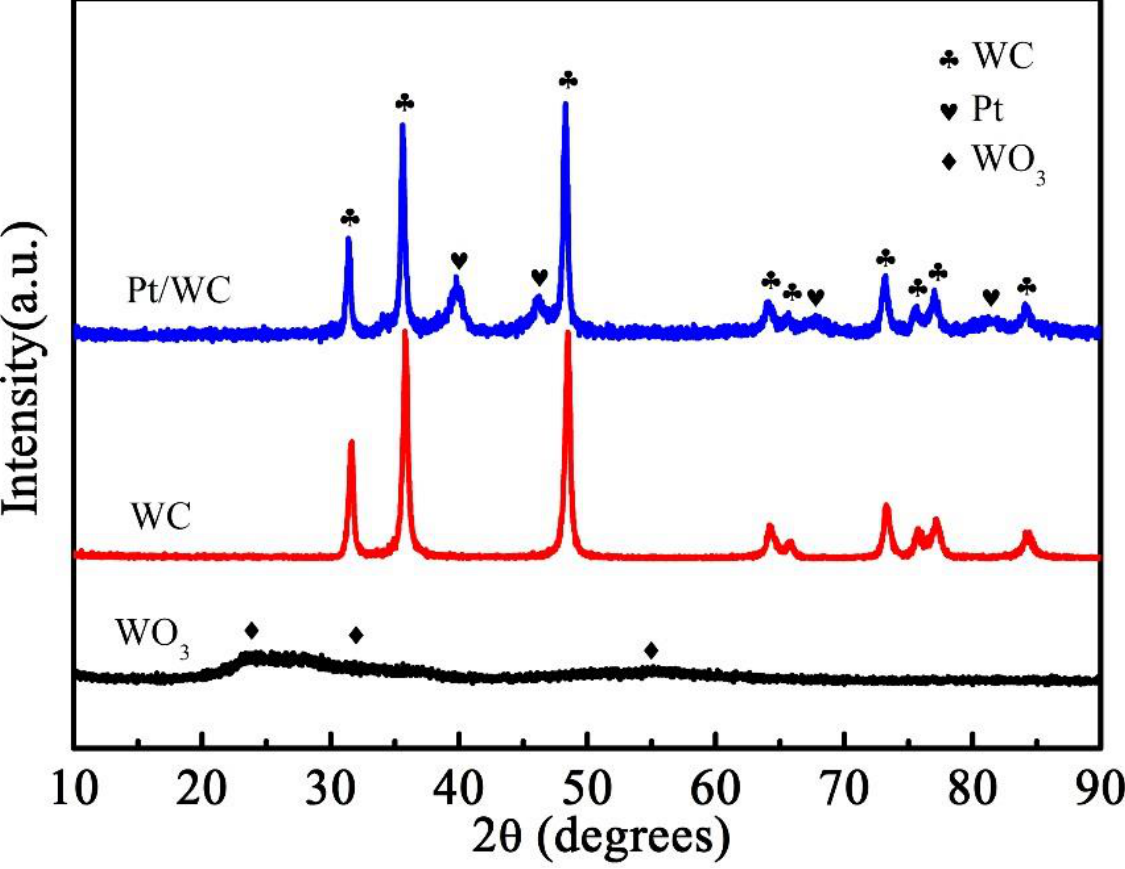
Figure 1. X-ray diffraction patterns of the WC precursor, WC and Pt/WC catalysts.